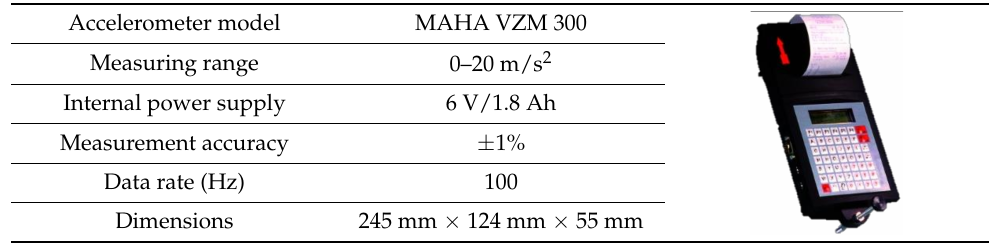
Table 3. Technical information of the accelerometer MAHA VZM